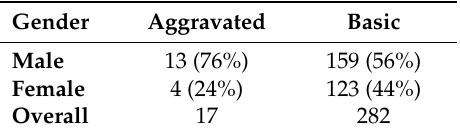
Table 4. Average penalties sentenced under section 13 of the AWA. Averages were calculated from the combination of pre and post amendments data and presented per charge of offence. Values in Table 5. Percentage of males and females involved in commission of aggravated and basic animal brackets indicate the number of charges. welfare offences. Numbers were derived from the combination of pre and post-amendments data; p -value =